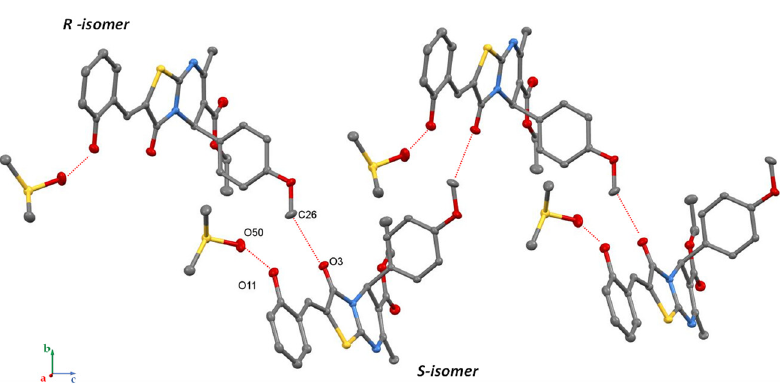
Figure 6. Portion of crystal structure of rac - 2b showing formation of 1D zigzag chain consisting of R- and S- isomers and ensured by intermolecular nonclassical CH…O H-bonding between methoxy carbon atom and oxygen of carbonyl group of thiazole moiety (view along c axis). Hydrogen bonds are shown in red dotted lines.